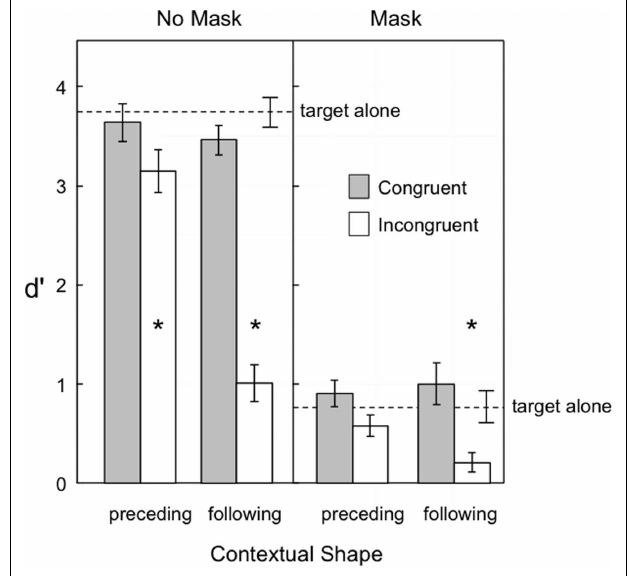
FIGURE 2 |Visibility of the target in Experiment 1, as indexed by d (cid:48) . Error bars represent ± 1 SEM.The asterisks indicate those conditions in which target visibility was significantly reduced relative to the target alone